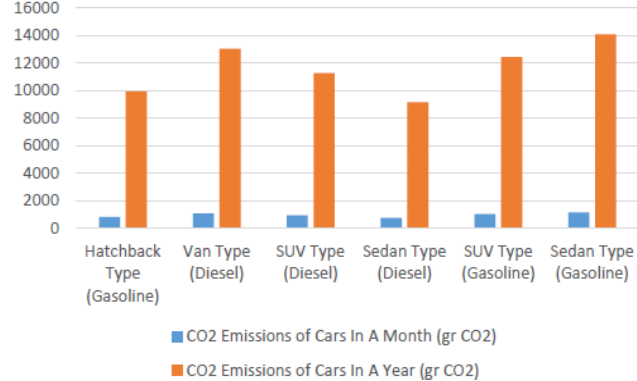
Figure 1. The CO emissions of cars without the system installed in the car park 2